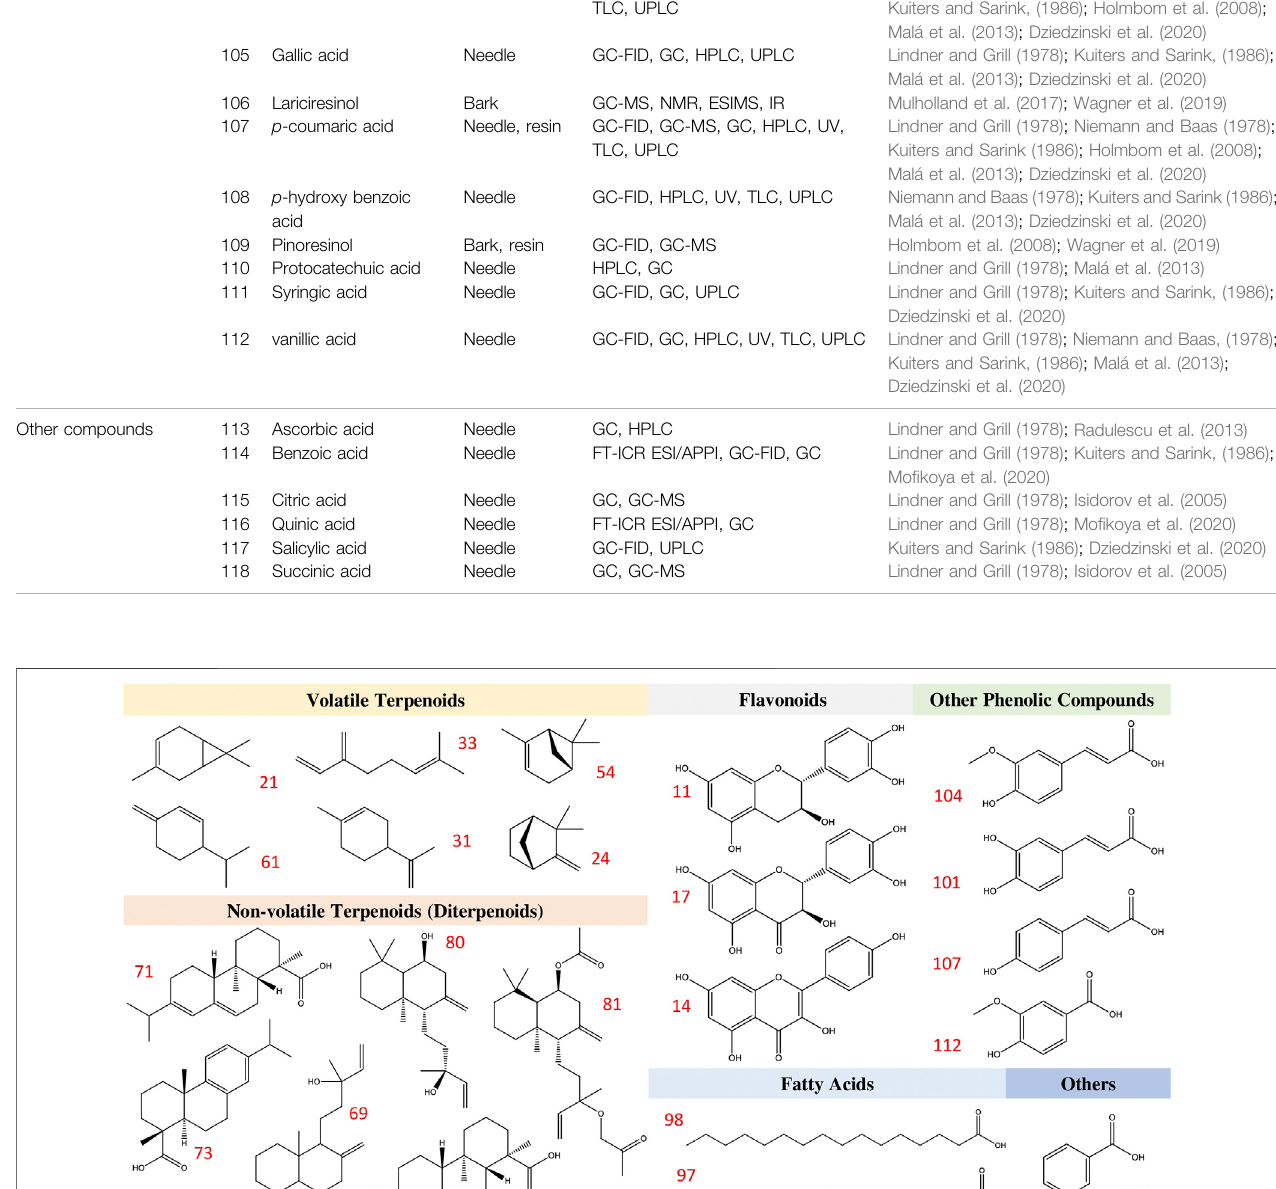
Frontiers in Pharmacology |